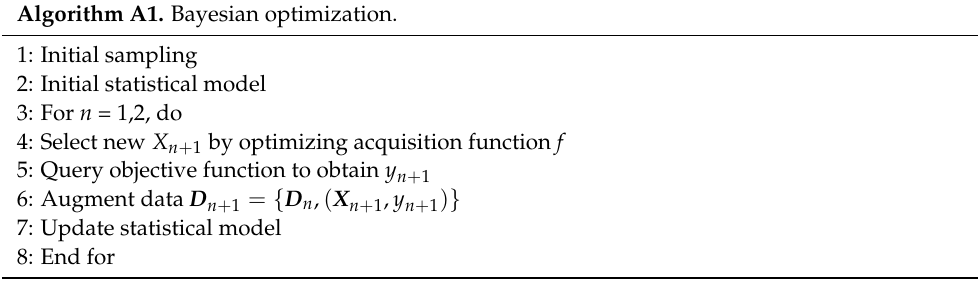
Algorithm A1. Bayesian